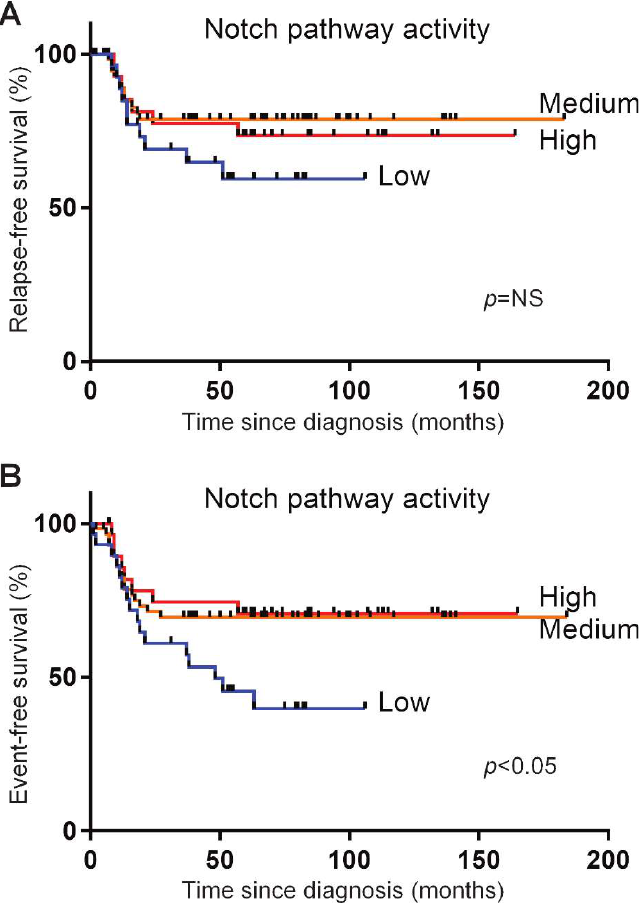
Figure 3. Relapse-free and event-free survival of T-ALL patients in three di ff erent Notch pathway activity groups. Three di ff erent Notch pathway activity groups were separated based on the lowest 25% Notch pathway activity (blue line), the highest 25% Notch pathway activity (red line), and the remaining 50%, termed the ‘middle’, Notch pathway activity (orange line). Relapse-free ( A ) and event-free ( B ) survival is plotted for the T-ALL pediatric patients treated on the DCOG ALL-7, -8 and -9 and COALL-97 protocols. p = NS (not significant) ( A ) and p < 0.05 ( B ) (log-rank test). Events include relapse, non-responsiveness to induction or maintenance therapy, change of treatment or death due to infection, toxicity or other